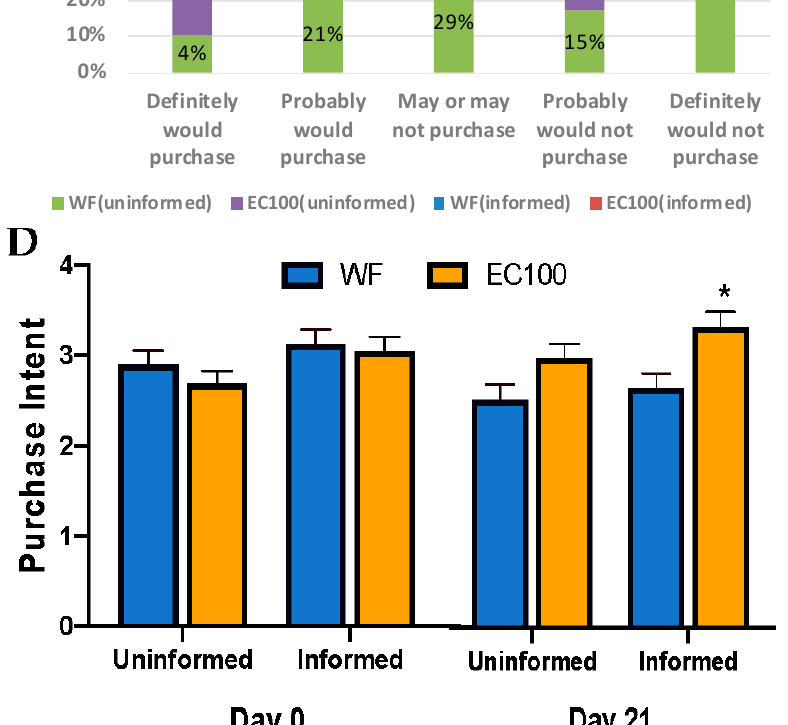
Figure 10. Purchase intent (means ± S.E.) of whole wheat flour (WF) roti (Indian flat bread) samples fortified with encapsulated defatted Nannochloropsis oceanica (EC) and color-masked defatted Nan- nochloropsis oceanica (CM) at day 21, ( A ) pre-claim, ( B ) post-claim, ( C ) comparison between WF and EC100 and ( D ) overall comparison between WF and EC100 on day 0 and day 21. * p < 0.05, n = 51.